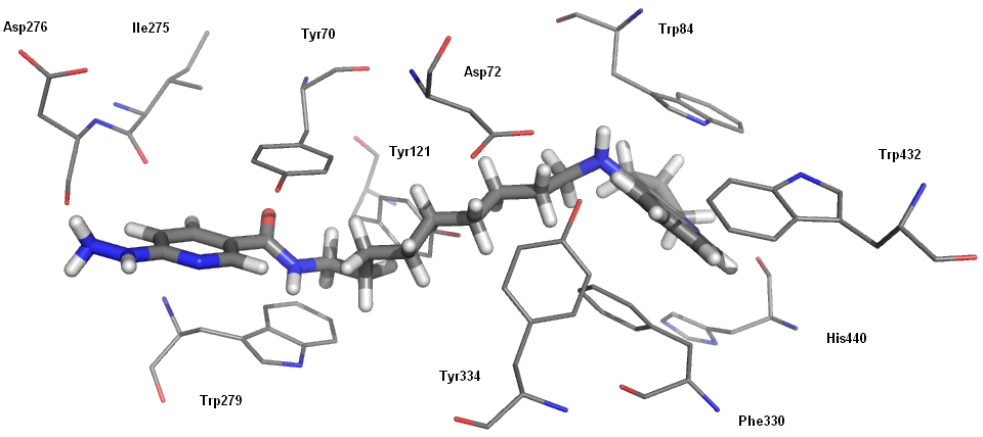
Figure 1. Binding mode of compound 6h with